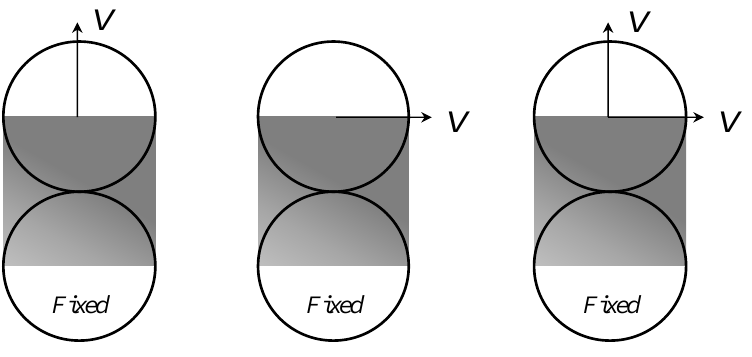
Figure 8. Constitutive model verification. Table 3. Micro-parameters used in the two-particle tests.